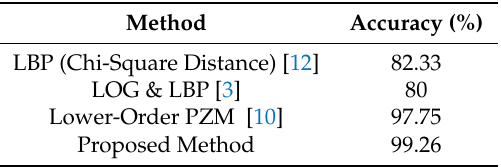
Table 2. Controlled environment. PZM: Pseudo Zernike Moments.